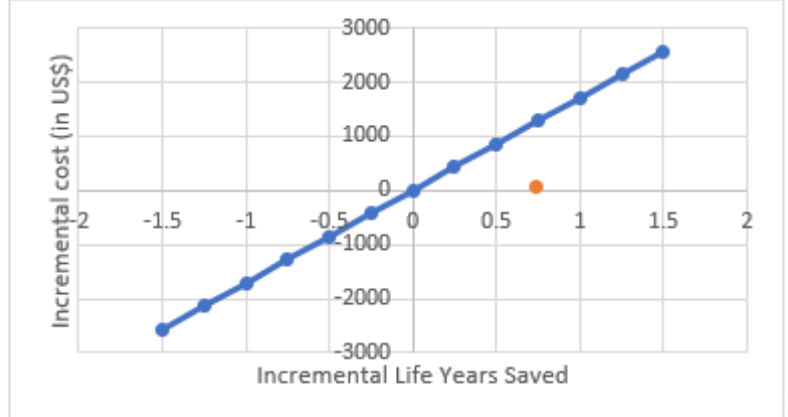
Figure 1. Cost-effectiveness plane with an incremental cost-effectiveness ratio,